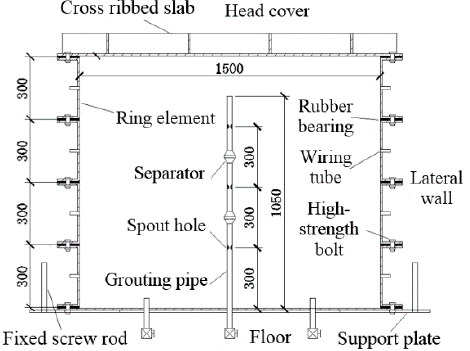
Figure 3. Internal structure of the simulated test.